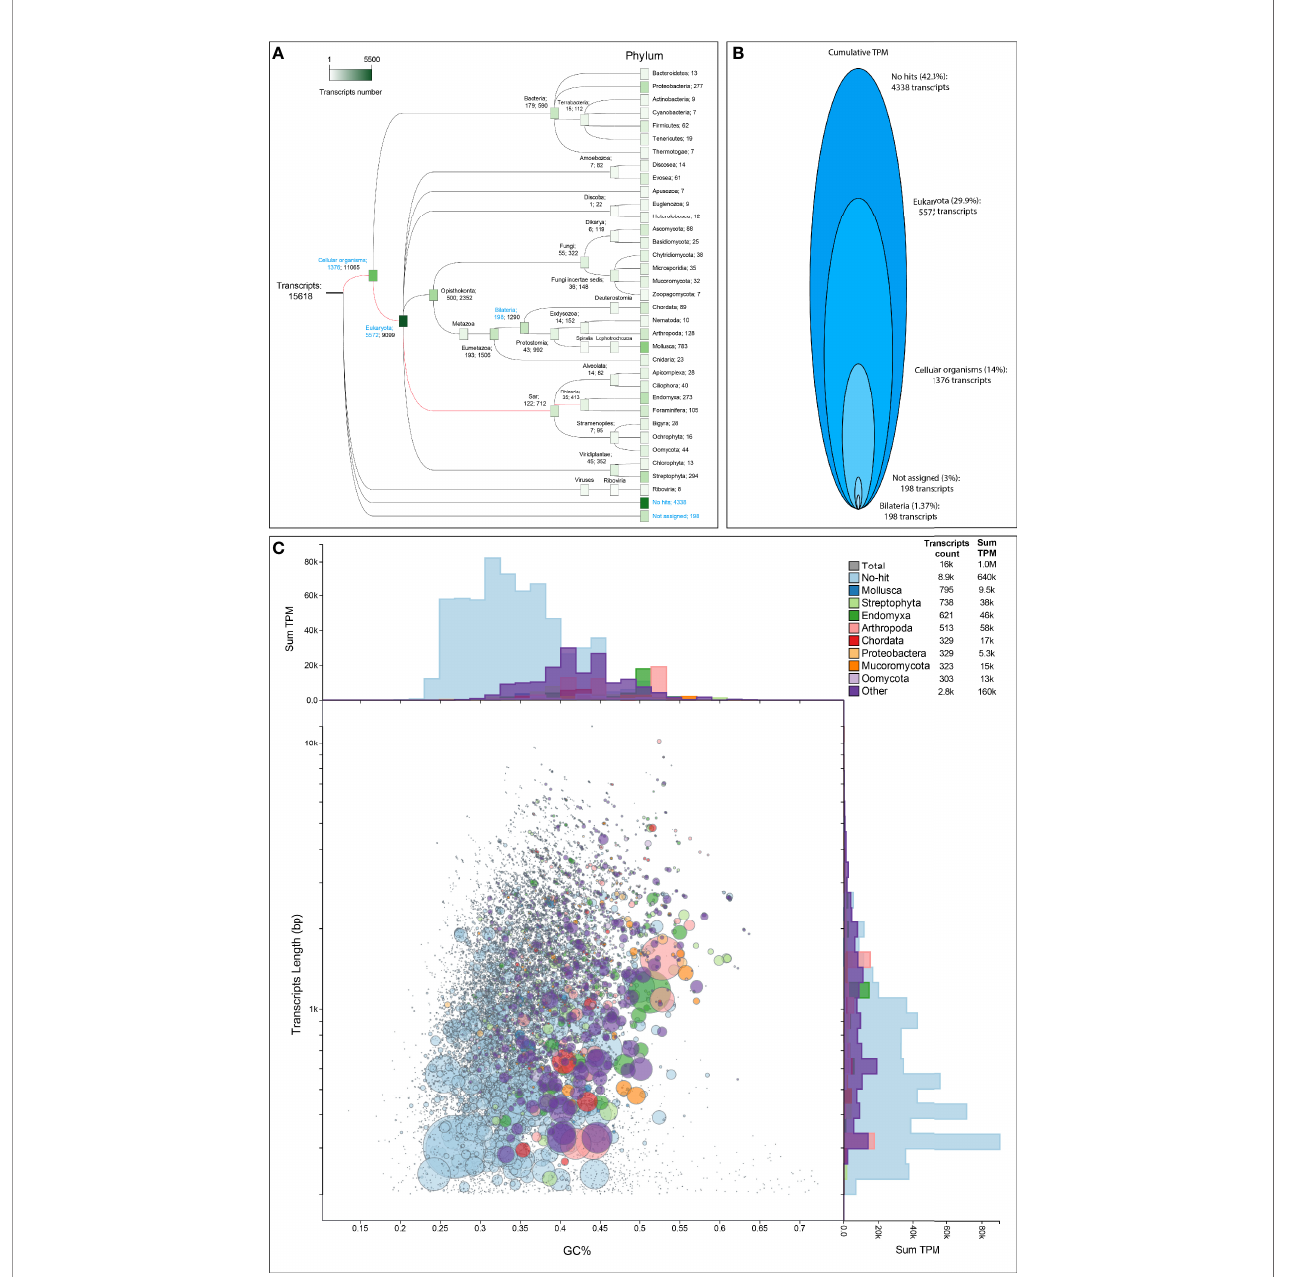
FIGURE 5 | Whole transcriptome taxonomic assignment. (A) Taxonomic assignment of transcripts using MEGAN following a DIAMOND-BlastX interrogation of the RefSeq database. The fi rst number for each clade corresponds to the number of transcripts assigned to this clade, whereas the second number corresponds to the number of transcripts assigned to the subsequent clades. Each clade is color coded from white (at least one transcript is assigned) to dark green (5,500 transcripts are assigned). Red branches correspond to the phylogenetic path to the Rhizaria clade. Blue clades correspond to clades for which cumulative expression has been plotted in (B) . (C) Taxonomic assignment of transcripts performed with BlobToolKit after a DIAMOND-BlastX interrogation of the RefSeq database and a BlastN interrogation of the nt database. A blob plot of length versus GC proportion for each transcript was created. Records are colored by phylum. Circles are sized in proportion to TPM on a square-root scale. Histograms show the distribution of TPM sum along each